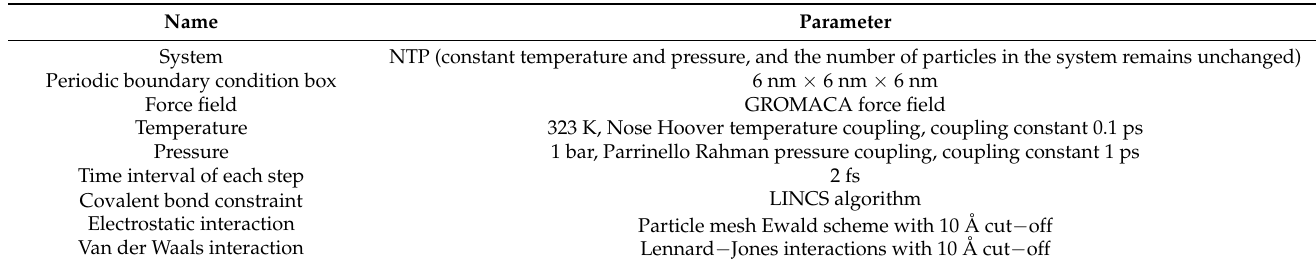
Figure 3. DPPC bilayer biofilm ( A ) and a new biofilm system of triptolide and DPPC ( B ). Table 4. Simulation parameters in molecular dynamics simulation Table 4. Simulation parameters in molecular dynamics